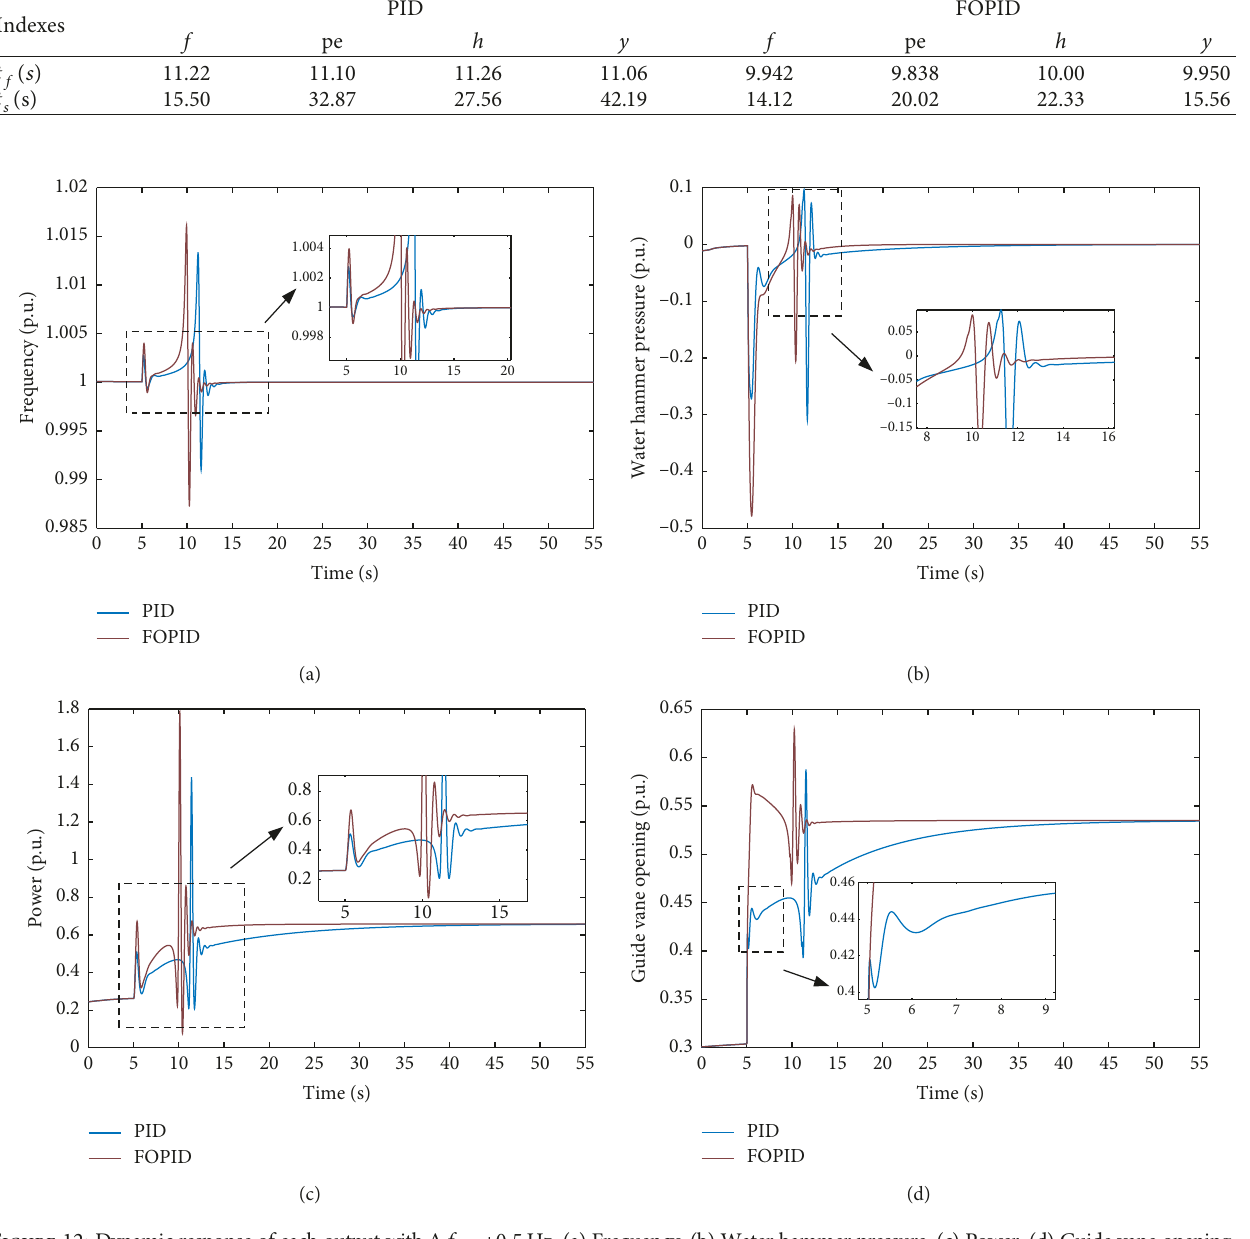
Table 14: Comparison of performance indexes with Δ f � + 0 . 5 Hz